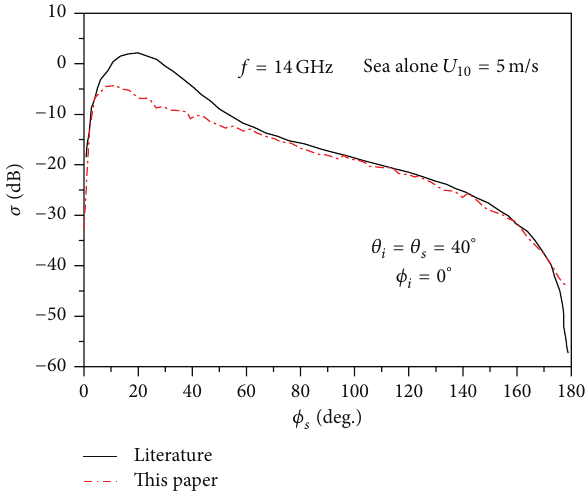
Figure 14: Comparison of bistatic scattering coefficient versus scattering azimuth angle.